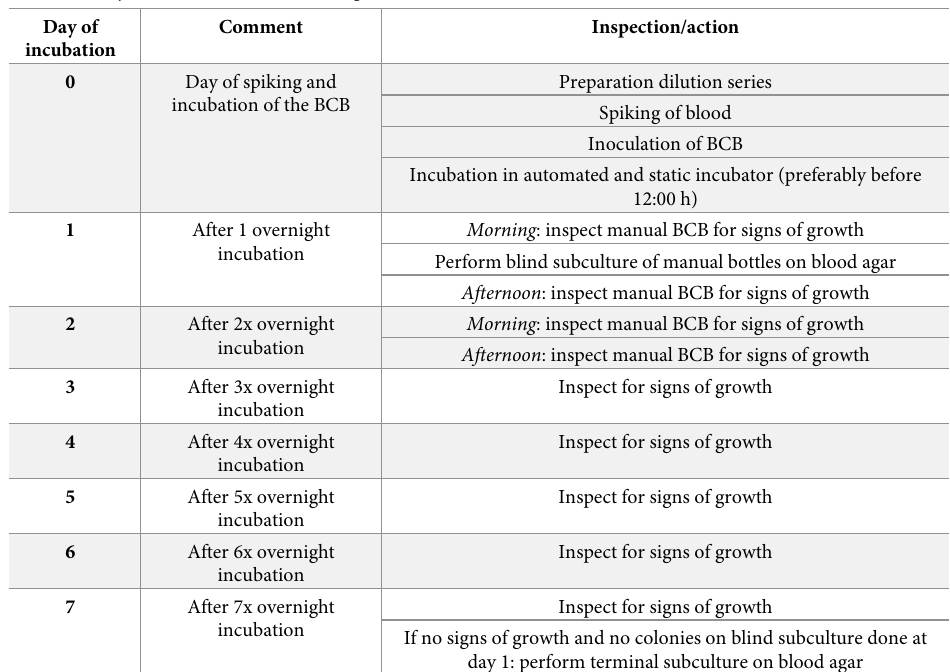
Table 5. Daily schedule of activities during a week of BCB